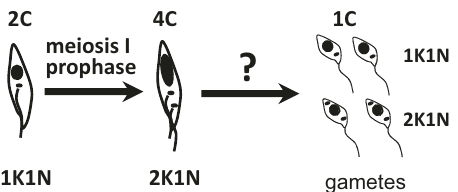
Fig. 1 Model of meiosis in Trypanosoma brucei . On the left, an epimastigote [kinetoplast (black dot) anterior to nucleus (black oval)] enters meiosis. Meiotic dividers expressing the meiosis-speci fi c proteins MND1, DMC1 or HOP1 have the morphology shown for the 4C trypanosome: a large posterior nucleus, two kinetoplasts, and two fl agella 14 . Haploid (1C) gametes are of two types: one kinetoplast, one nucleus (1K1N) and 2K1N 15 and it is assumed that four are produced from each trypanosome that enters meiosis. The question mark signi fi es the current gap in knowledge about intermediate stages in